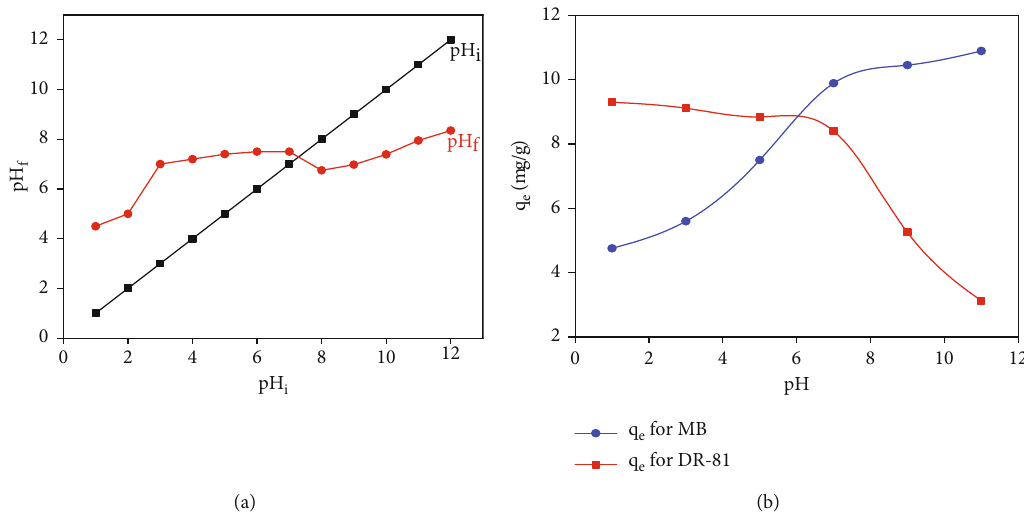
Figure 9: (a) The pH of the synthesized Zn-adeninate bio-MOF and (b) the e ff ect of pH on the adsorption capacity of the synthesized Zn- pzc adeninate bio-MOF for MB and DR-81 (contact time = 10 min for MB and 30 min for DR-81, bio-MOF dosage = 1 g L − 1 , initial dye concentration = 10 ppm, stirring speed = 300 rpm, and solution temperature = 23 ° C)